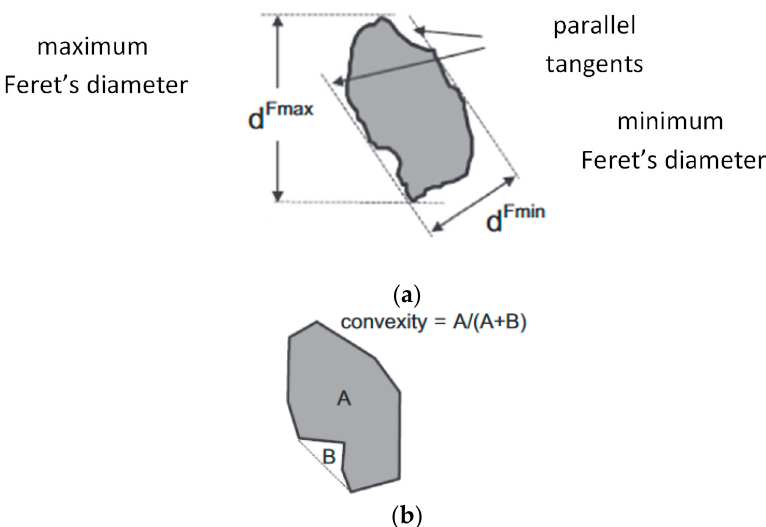
Figure 5. ( a ) Idea of Ferets’ diameters; dFmin—minimal Feret’s diameter, dFmax—maximum Feret’s diameter [38]. ( b ) Particle convexity; A—convex surface of the particle, B—concave surface of the particle [38].